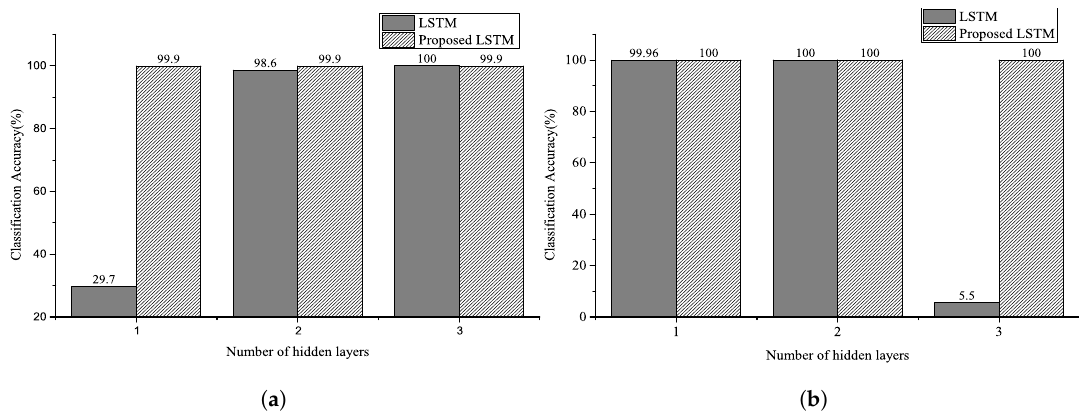
Figure 8. Classification accuracy for NSRDB using two selected parameters: the number of hidden unit of ( a ) is 128 and number of hidden unit of ( b ) is 250. The input sequence length is 2–4 for the number of heartbeats (Experiment